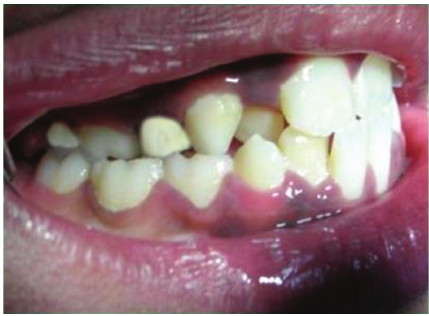
Figure 1: Lateral intraoral view showing anterior and posterior crossbite on the right side.